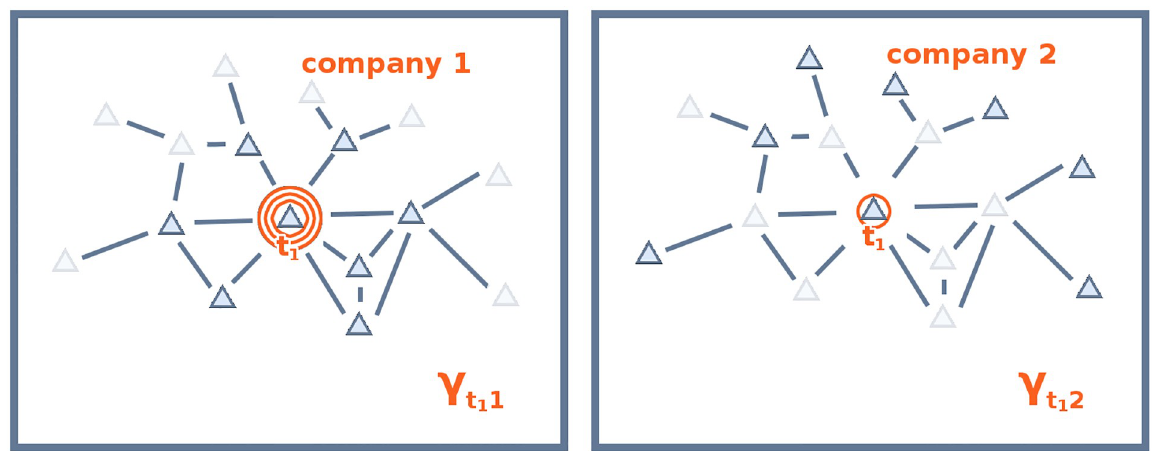
Fig 5. Illustration of γ for a generic technology t 1 and two firms (1 and 2), depicted respectively in the left and right panels. In both panels, the graph represents the binary B of Fig 3 (right): the opaque triangles stand for technological fields in which the associated firm holds patents. Both firms are diversified in the same number of technological fields. However, those of firm 1 are connected within B forming a unique block; on the contrary, those of firm 2 are scattered through the graph. As a consequence, technology t 1 is highly coherent in firm 1 but not in firm 2.